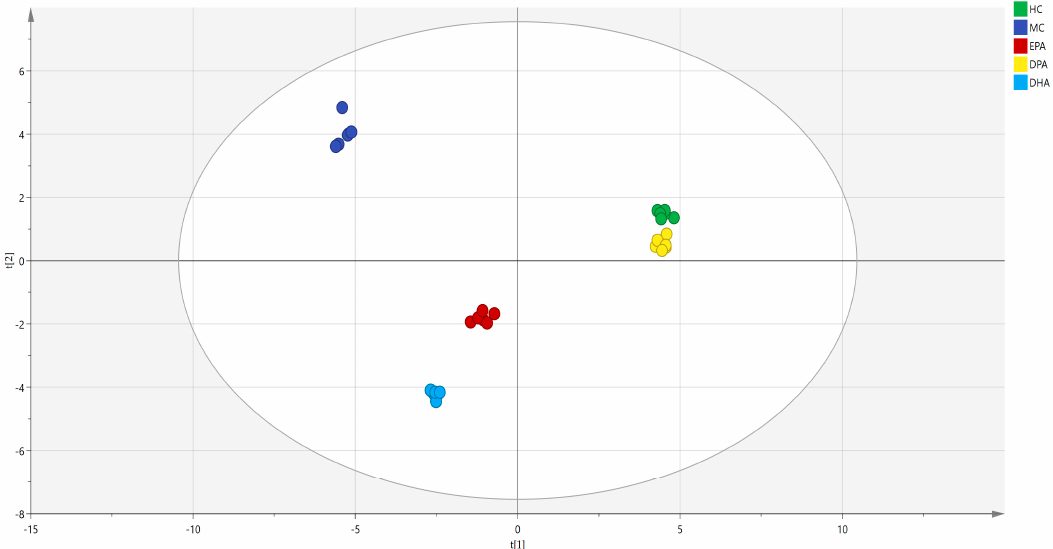
Figure 3. The correlation analysis of the gut microbiota in different groups was evaluated by PCA. Note: t (1) and t (2) represent the corresponding explanation rate of principal component 1 (56.2%) and principal component 2 (31.4%); EPA, DPA, DHA, MC, HC represent EPA group, DPA group, DHA group, model control group, health control group, respectively.